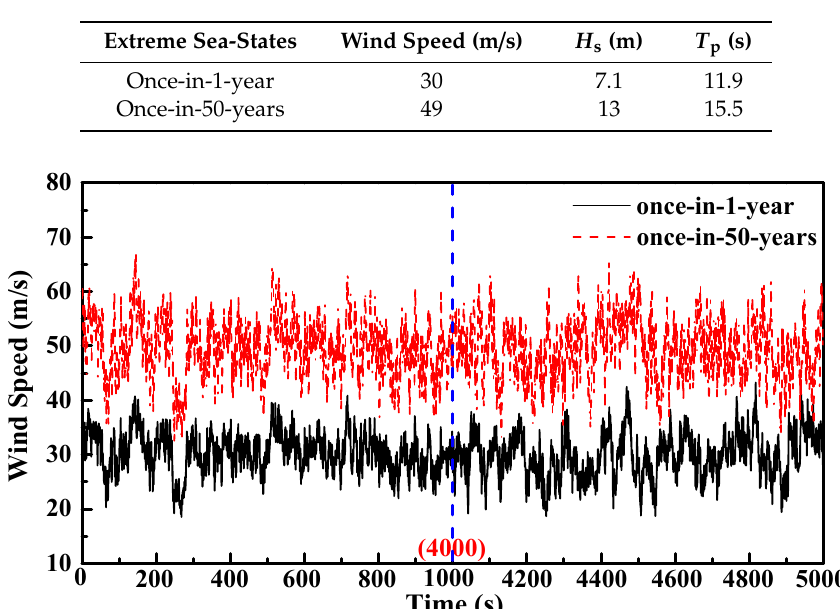
Figure 11. Time series of wind speed under extreme sea-states.